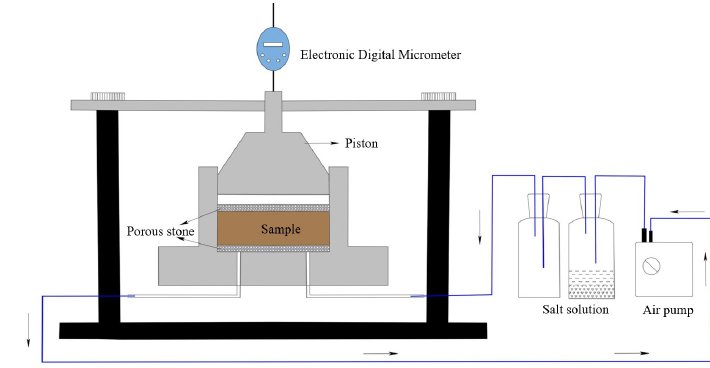
Figure 2. Experimental equipment of suction controlled compression. Table 1. Physical parameters and dimensions of sample for suction controlled